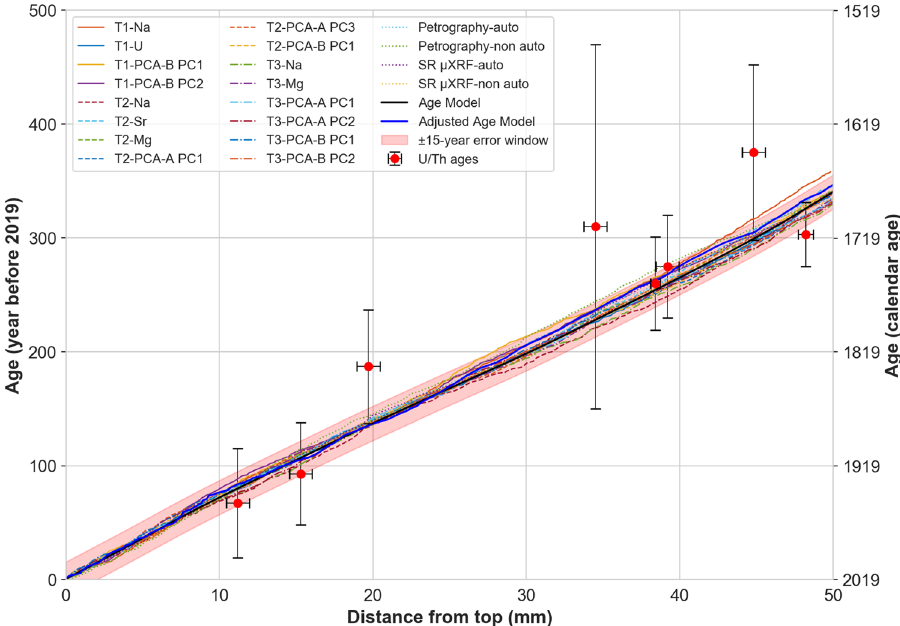
Figure 5. Selected time-depth curves, calculated (solid black) and adjusted (solid blue) master curves. The ± 15-year error window (red band) envelopes all the selected curves for most of the age interval. The red circles and vertical capped lines demonstrate the U/Th ages and associated uncertainties.